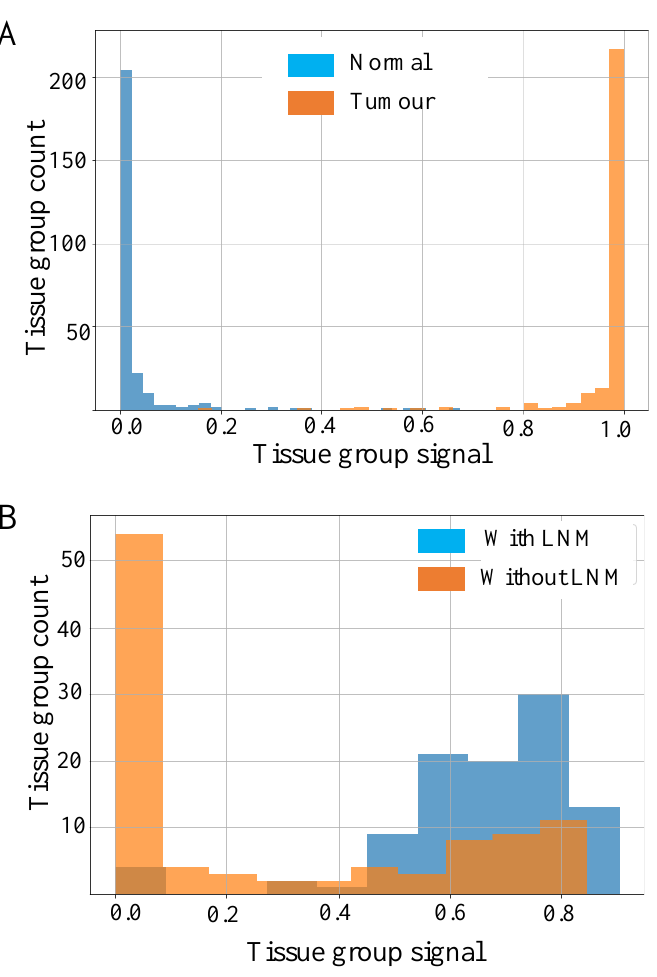
Figure 5. Histograms of the classifier signal produced by the final design for per-tissue-group classification for CRC ( A ) and EC ( B ). For CRC, the blue histogram is for normal tissue groups, and orange is tumour tissue groups. For EC, the data is aggregated over all 10 validation folds; the blue histogram is for LNM, and orange is for non-LNM samples.